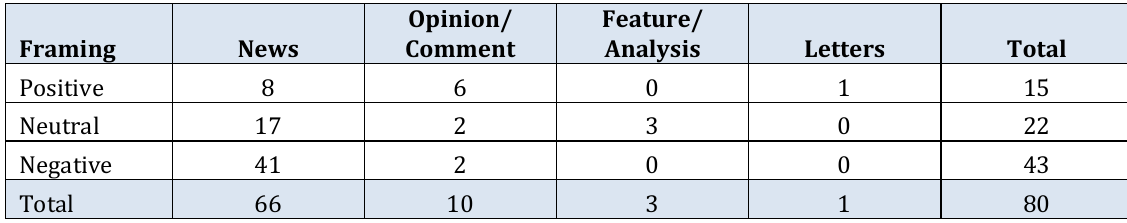
Table 3: Framing by Article